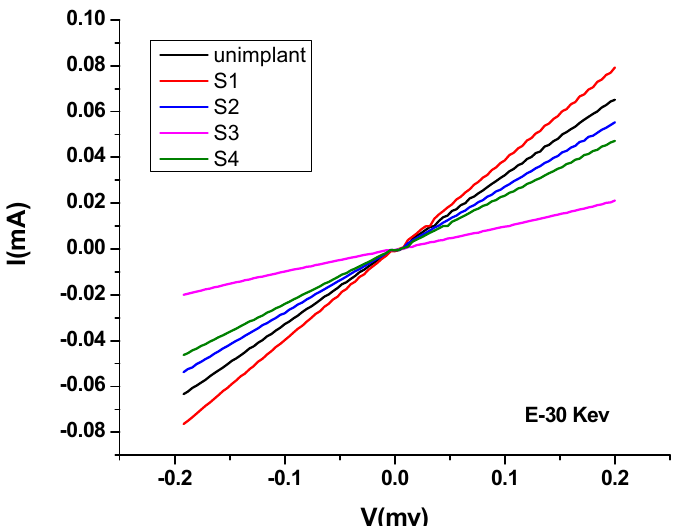
Fig. 9. Variation of voltage as a function of current for unplanted and Nitrogen ion implanted Ta.